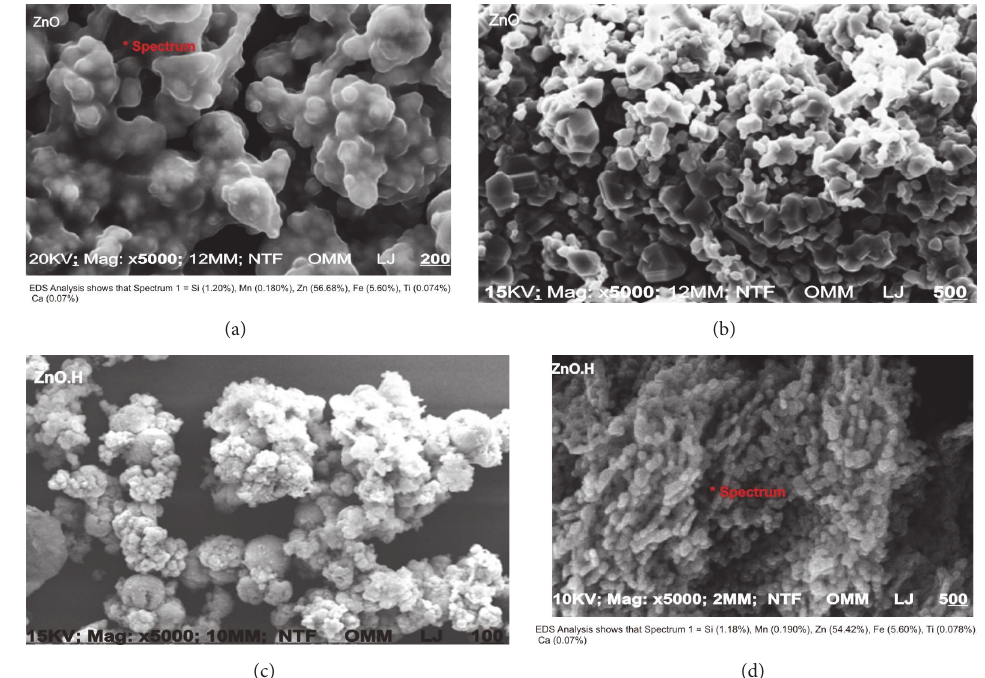
Figure 4: SEM micrographs of 0.02% starch (a-b) ZnO and (c-d) ZnO:H (2) , respectively, with their EDS on (a) and (d), respectively.